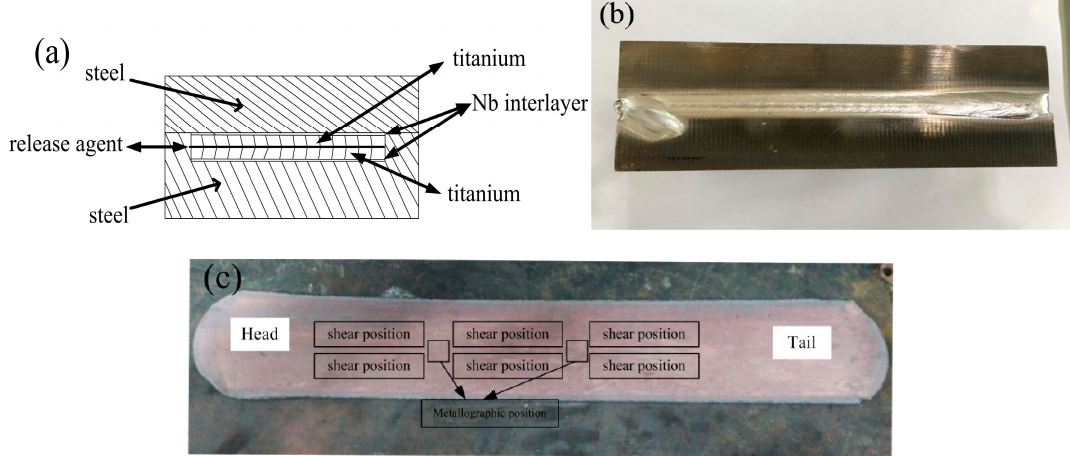
Figure 1. Principle drawing of the assembling Ti/steel ( a ); blank morphology after welding ( b ) and samples locations for microstructure and mechanical testing ( c ).